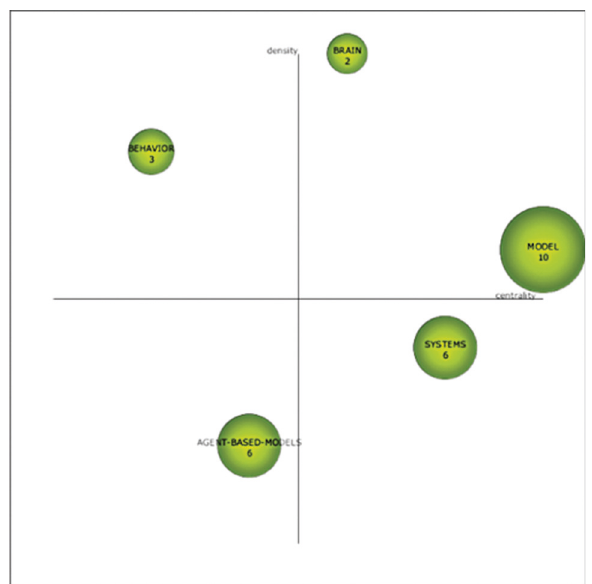
Figure 17: 2006–2010 strategic coordinate chart.